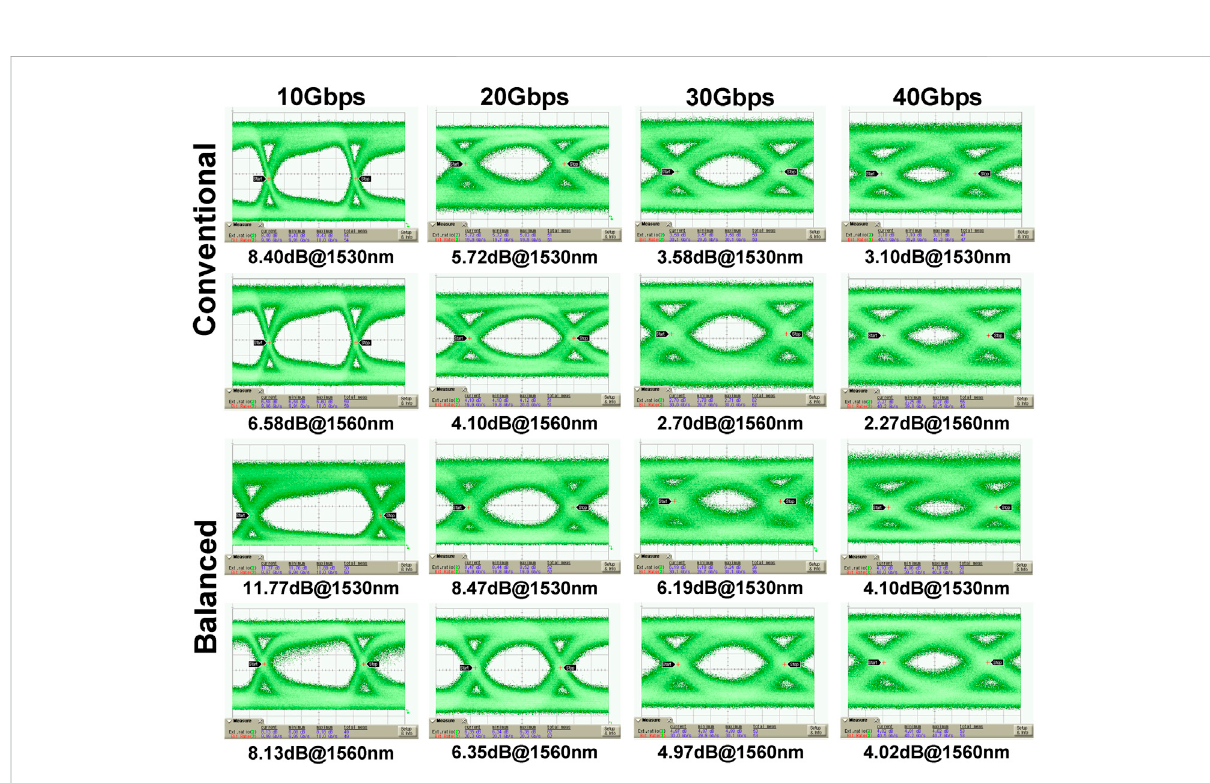
FIGURE 7 The eye diagram for both conventional symmetric MZM and light-intensity-balanced MZM under the speed of 10Gbps, 20Gbps, 30Gbps and 40Gbps for both 1530nm and 1560